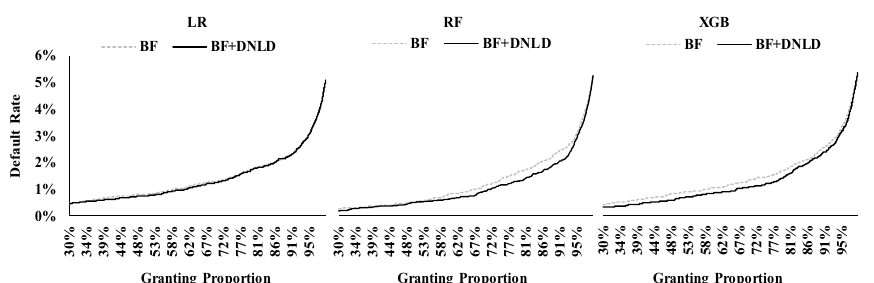
Fig. 8 Granting performance of two models on NEEQ SMEs Dataset. The horizontal axis represents different granting proportions of loans ranging from 30 to 95%. The vertical axis is the default rate ranging from 0 to 5.1%